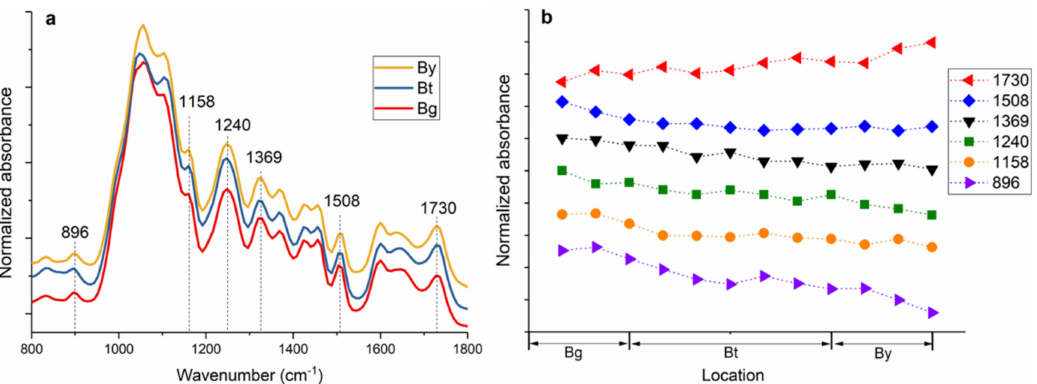
Figure 1. ( a ) FT-IR spectra of fiber sheath extracted from Bg to By; ( b ) Change in relative intensity of absorbance bands for fiber sheath from Bg to